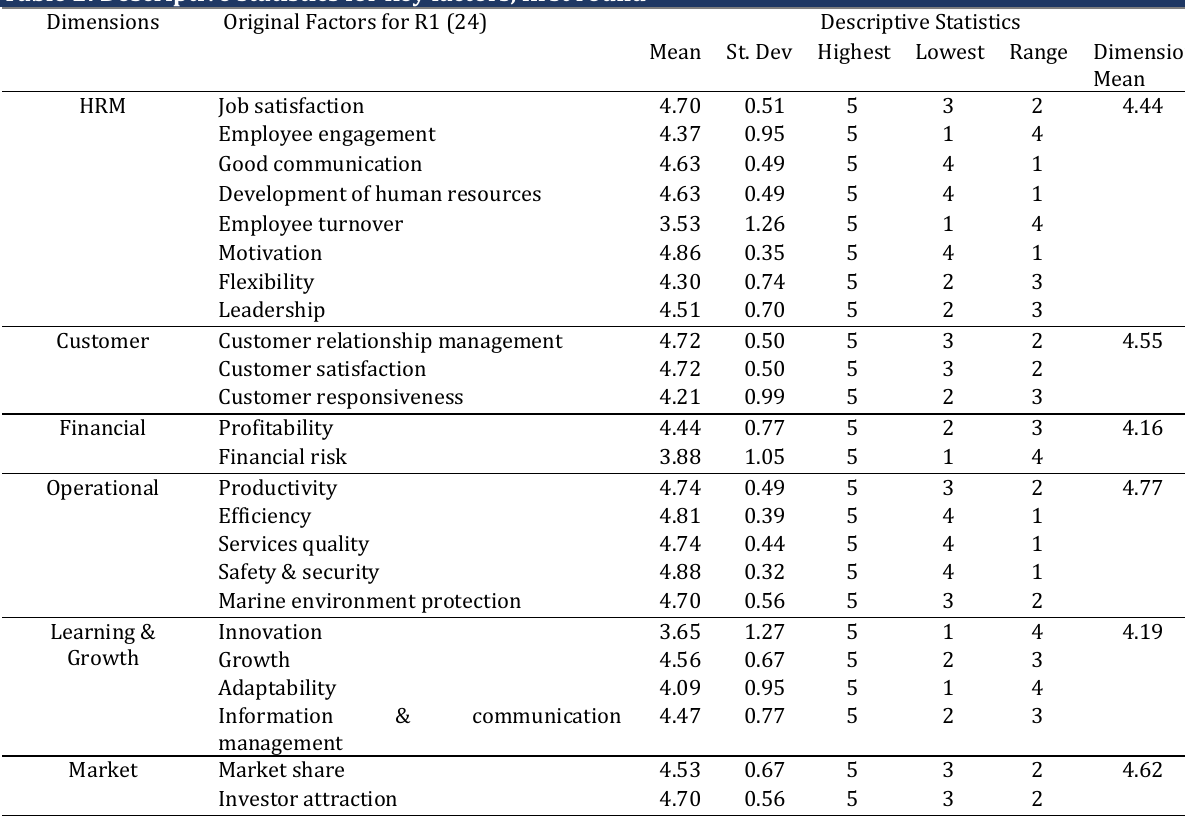
Table 2: Descriptive statistics for key factors, first round Dimensions Original Factors for R1 (24) Descriptive Statistics